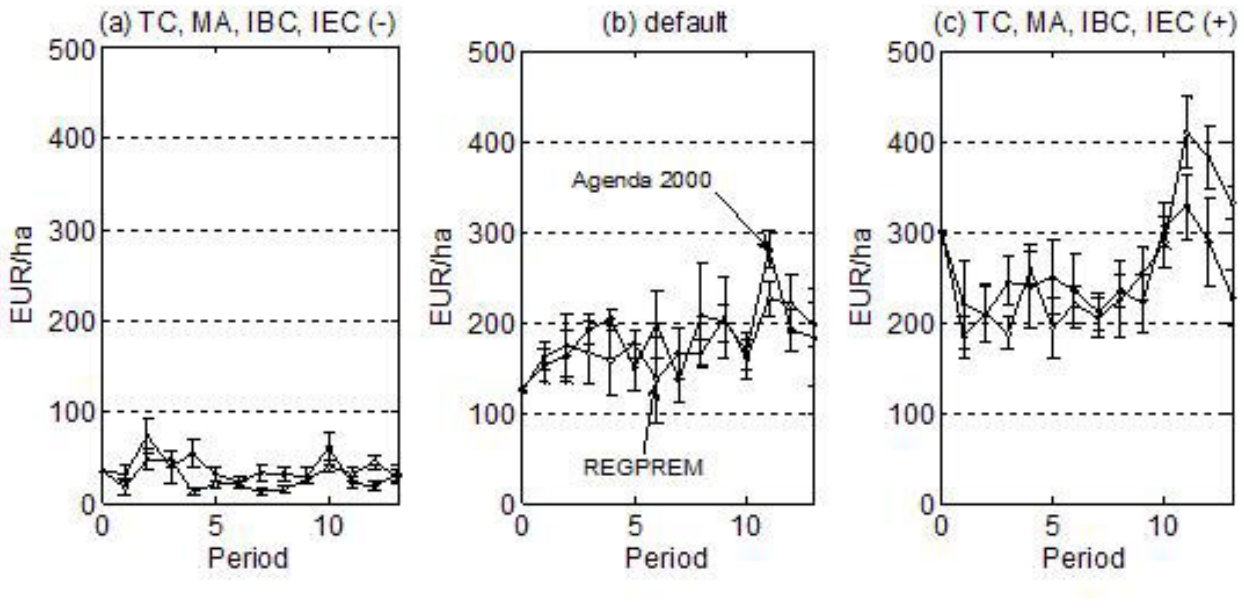
Fig. 7. Evolution of sunk costs per hectare over 14 simulation periods and two policies, i.e., Agenda 2000 and the decoupled policy (REGPREM) for low factor levels (-), default, and high factor levels (+). Averages of five replications and standard errors. IBC is interest on borrowed capital, IEC, interest on equity capital, MA, cost savings due to managerial ability, and TC, technological